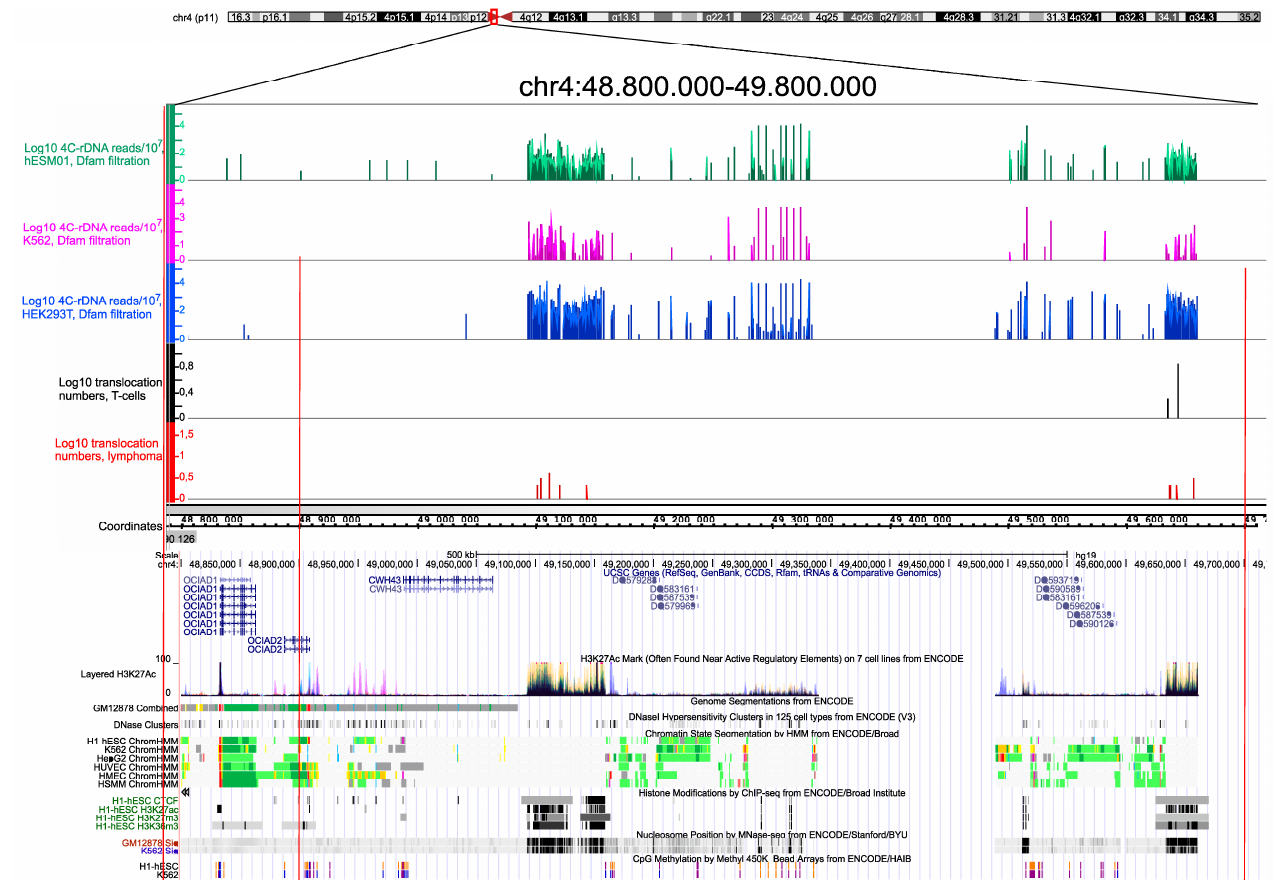
Figure 3. Translocation sites in both normal T cells and in NK-cell lymphomas coincide with and correspond to the hot spots of rDNA contacts in three human cell lines of different origin. The distribution of rDNA-contacting sites in K562 cells, HEK293T, and in hESM01 cells [24] in the pericentromeric region of chr4 are shown as in IGB Browser (hg19). The translocation sites detected in 102 samples, each containing amplicons from T cells and NK-cell lymphomas from the same individual, are shown. The distribution of UCSC genes, layered H3K27ac marks, genome segmentation from ENCODE, histone modifications, nucleosome position, and CpG methylation inside of a 1-Mb region of chr4 are shown as in the UCSC Browser (hg19).